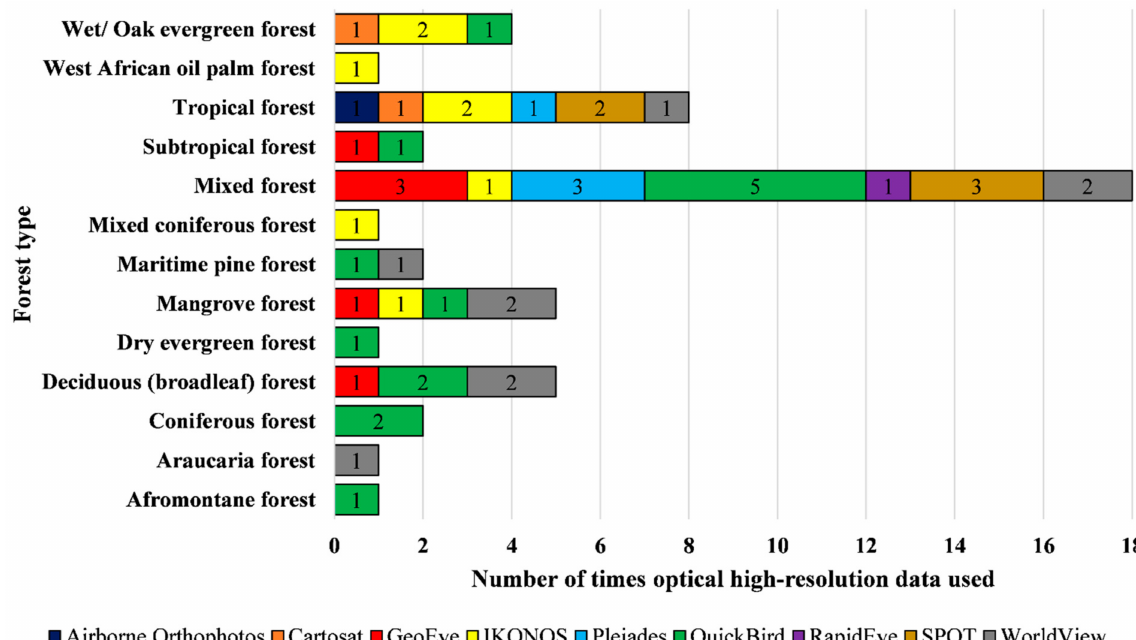
Figure 4. Number of times high-resolution optical data were used for each distinctive forest